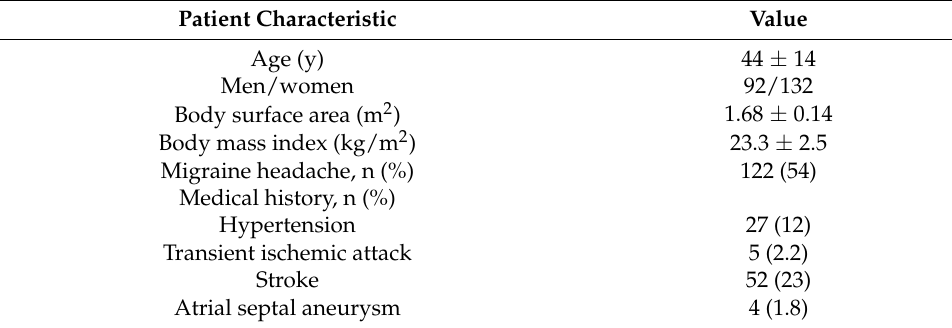
Table 1. Patient characteristics of the study